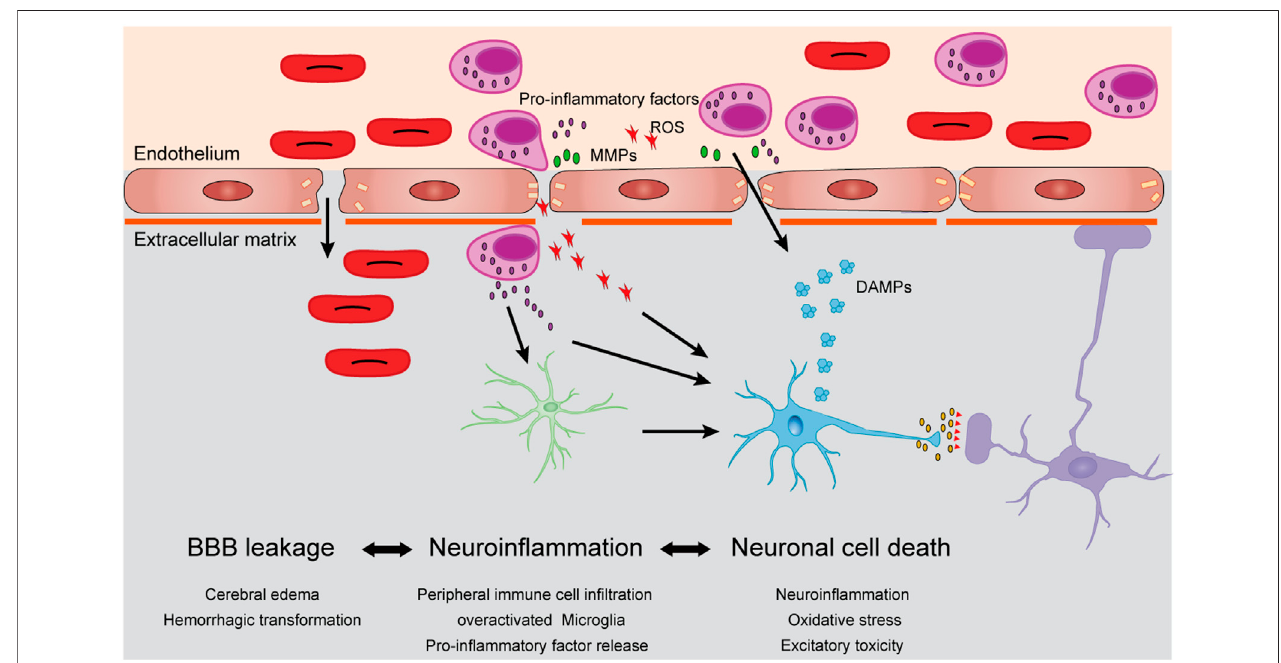
FIGURE 1 | Cellular mechanisms of cerebral ischemia/reperfusion injury. After stroke, dying cells from ischemic brain tissue begin to produce damage-related molecular patterns (DAMPs), which induced circulating neutrophils to in fi ltrate into ischemic brain parenchyma. Neutrophils released matrix metalloproteinases (MMPs), reactive oxygen species (ROS) and pro-in fl ammatory factors, accelerate their in fi ltration and damage the vascular endothelial cells and extracellular basal membrane, which induced brain edema and even hemorrhagic transformation. A large number of in fl ammatory factors and ROS can also stimulate the overactivation of microglia, which further aggravates neuronal damage caused by neuroin fl ammation and leads to neuronal death.